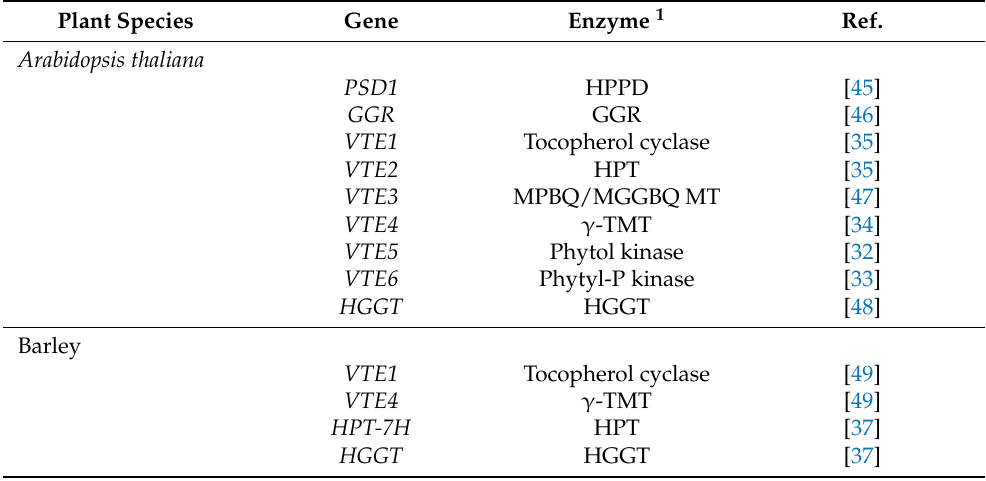
Table 1. Key genes involved in tocochromanol biosynthesis in Arabidopsis thaliana and various cereal